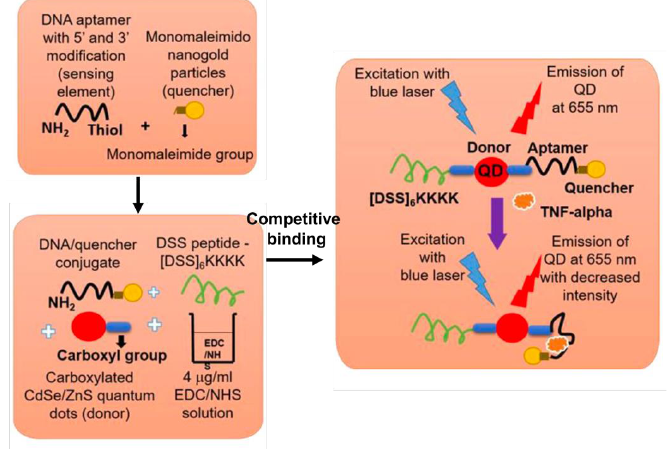
Figure 2. Quantum dot (QD) biosensing strategy based on change in optical signal of QD by materials directly attaching to the aptamer. CdSe/ZnS QD biosensor to the detection of intracellular tumour necrosis factor-alpha (TNF-α). Reproduced with permission from [35]. EDC, 1-Ethyl-3-(3-dimethylaminopropyl) carbodiimide hydrochloride; NHS, N -hydroxysuccinimide. A QD-NP composite can exhibit the FRET effect in the UV-visible range, where the QD acts as a donor and the NPs act as acceptors that can quench or cause a release of photons [34–36]. For example, intracellular tumor necrosis factor-alpha (TNF-α) could be detected using the QD-AuNP sensing material [34]. The sensing platform comprised a